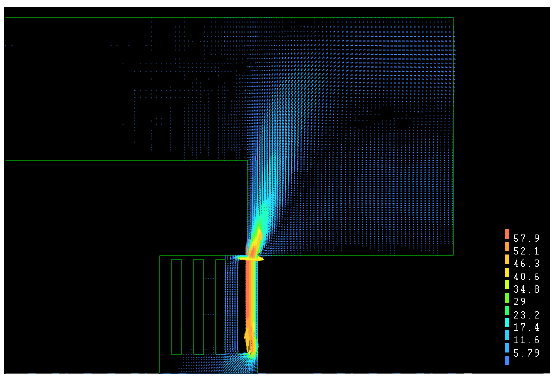
Fig. 9. Outcoming airflow in the plan when the upper edge of the side electrode located at the same height as the below edge of the central